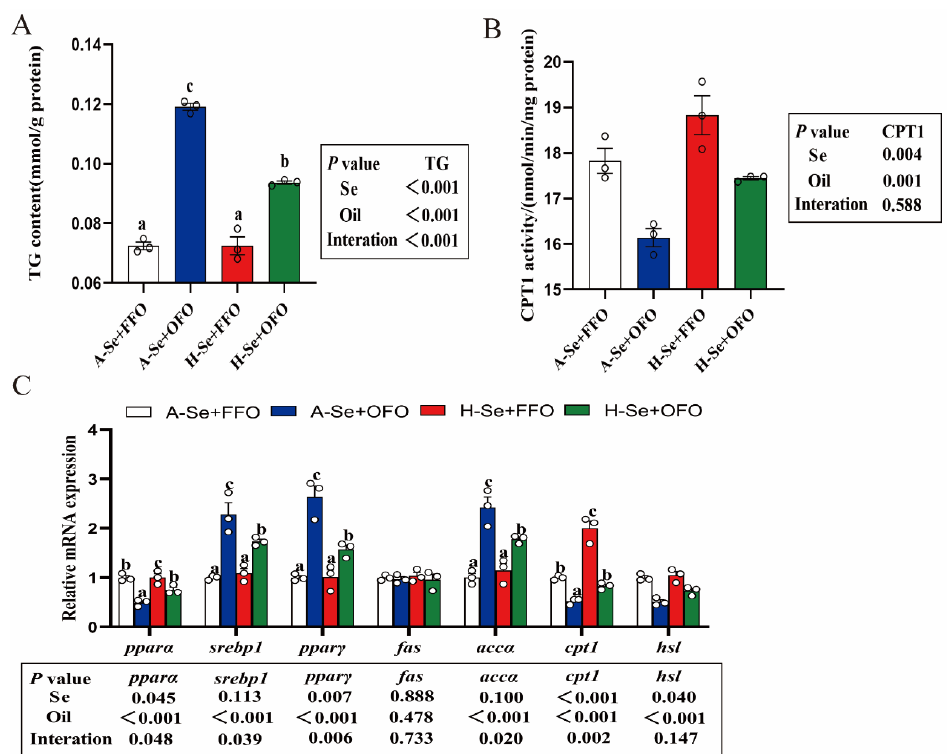
Figure 2. High levels of selenium reduced the oxidized fish oil-induced lipid deposition in the intestine of yellow catfish. ( A ) TG content. ( B ) CPT1 activity. ( C ) The expression of mRNA related to intestinal lipid metabolism. All data were mean ± SEM ( n = 3). “a–c” indicate meaningfulness at p < 0.05. p value was calculated by two ‐ way ANOVA. TG, triglyceride; CPT1, carnitine palmitoyl transferase 1.